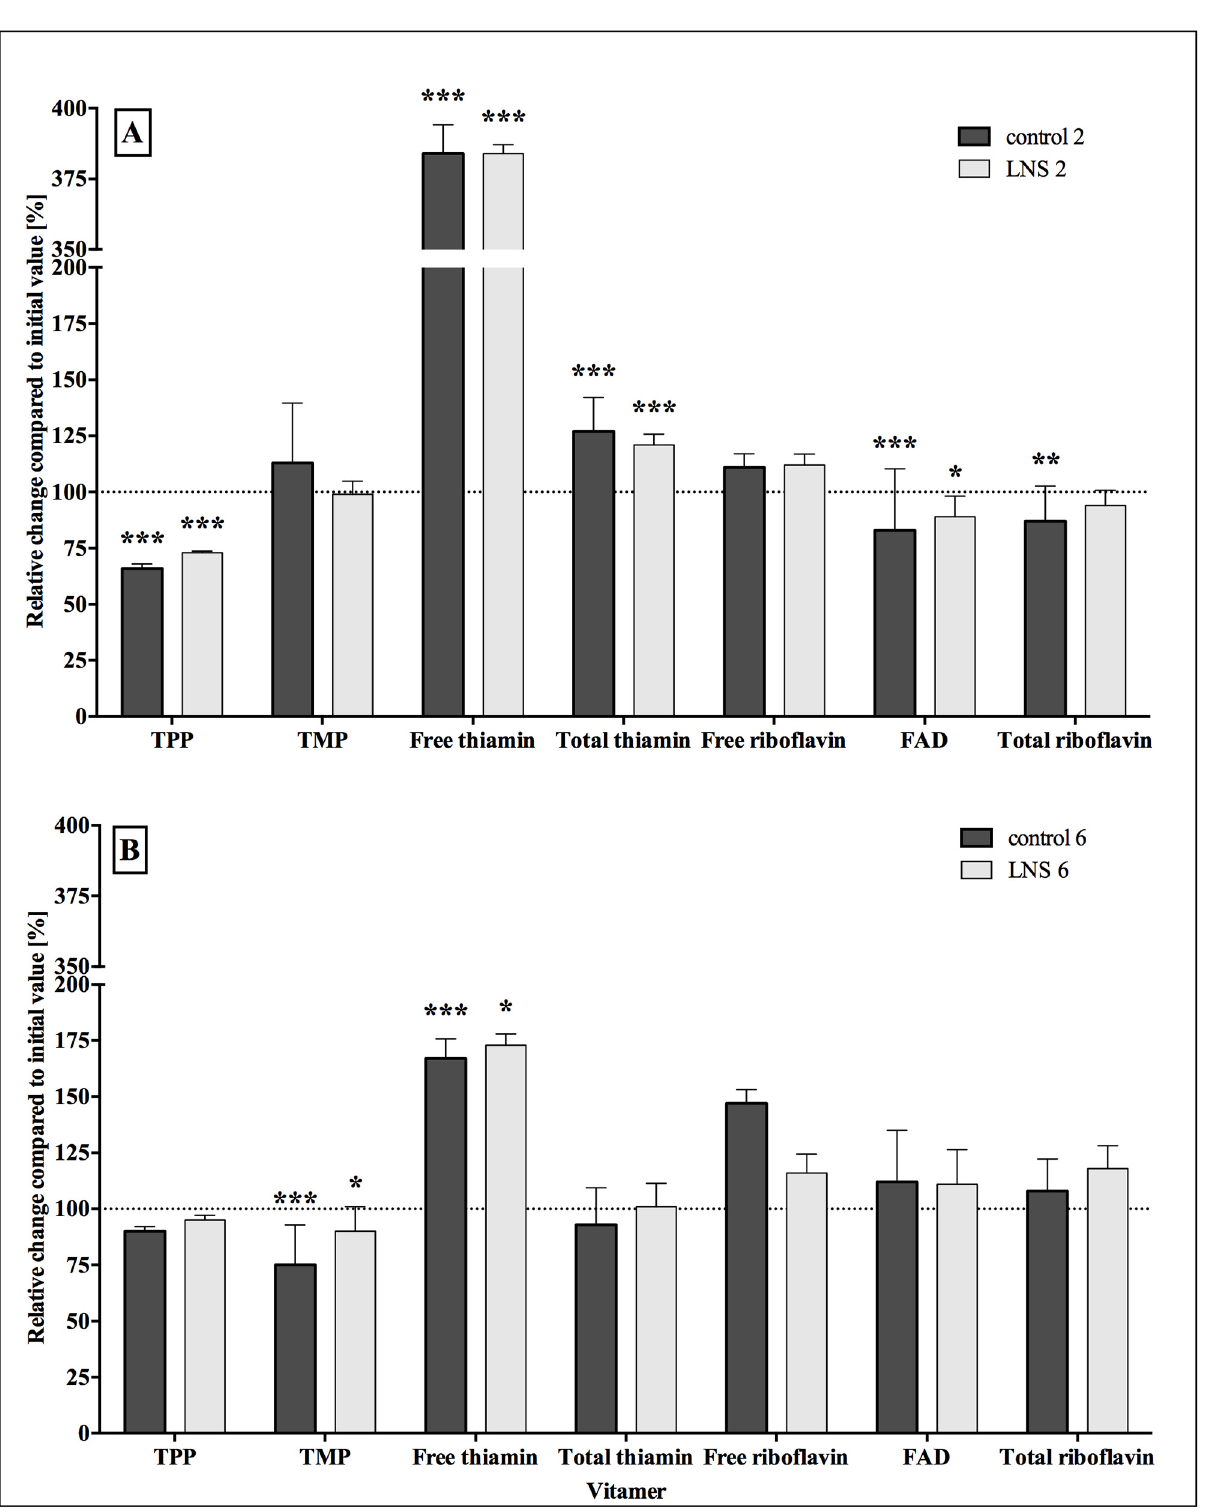
Fig 1. Percent change of concentrations and 95% confidence interval (CI) for each thiamin and riboflavin vitamier at 24 wk compared to the initial value (2 or 6 weeks, A and B respectively) by treatment group (control or LNS). Means were compared by paired t-test to evaluate changes over time within treatment and sub-set). Asterisks indicate level of significance compared to initial value ( * , p < 0.01, ** ; p < 0.01; *** , p < 0.001). Control 2: control